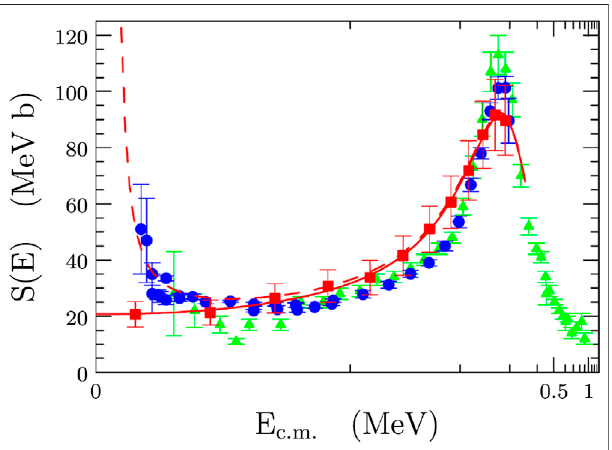
FIGURE4| TheS(E)-factorof 9 Be(p, α ) 6 LiviaTHM(redpoints)compared to the direct data (green and blue points). The solid red curve describes the fi t of the bare-nucleus THM data, leading to S (0) (cid:2) 21.0 ± 0.8 MeV barns. The red dashed line describes the enhancing caused by electron screening effects with a fi tted value of U e (cid:2) 676 ± 86 eV, as given in Wen et al.